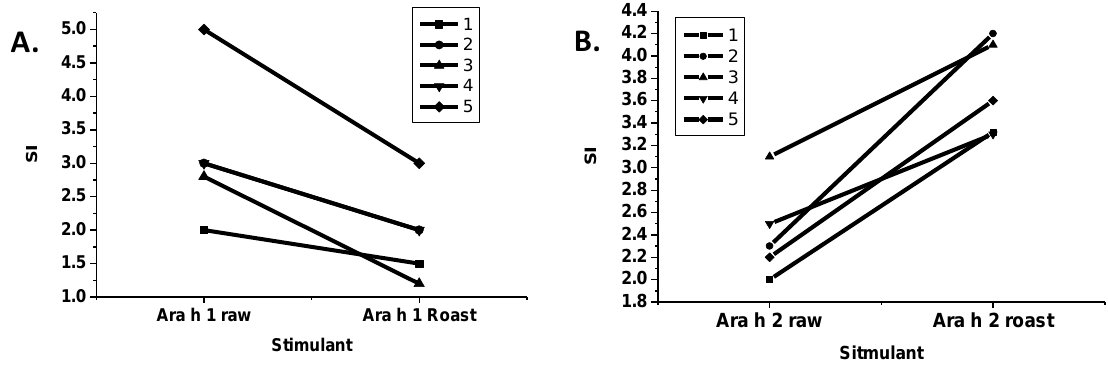
Figure 5. T-cell response to Ara h 1 and 2 purified from raw and roasted peanut extracts. Lymphocytes from five peanut allergic individuals were stimulated with Ara h 1 ( A ) or Ara h 2 ( B ) purified from either raw or roasted peanuts. The stimulation index (SI) is shown on the y